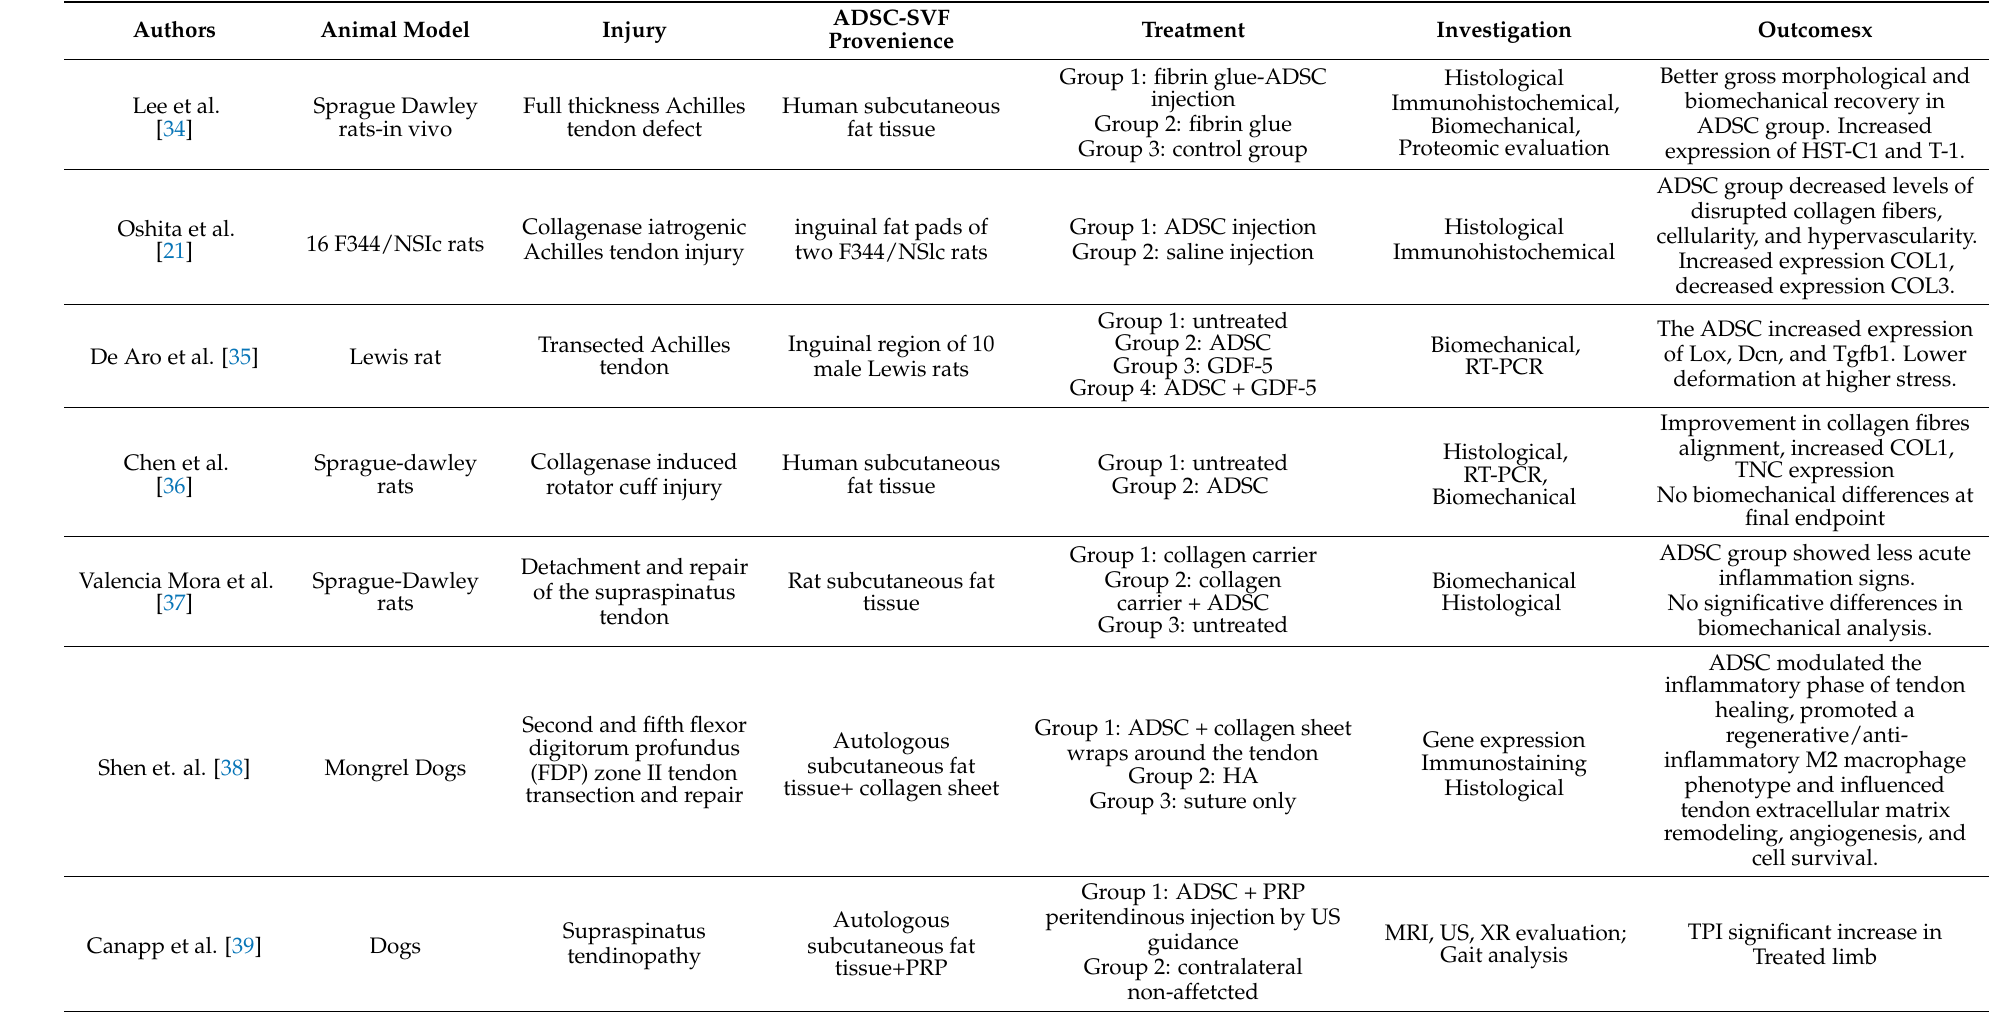
Table 1. Enzymatically derived ADSC/SVF in animal model tendinopathy and tendon